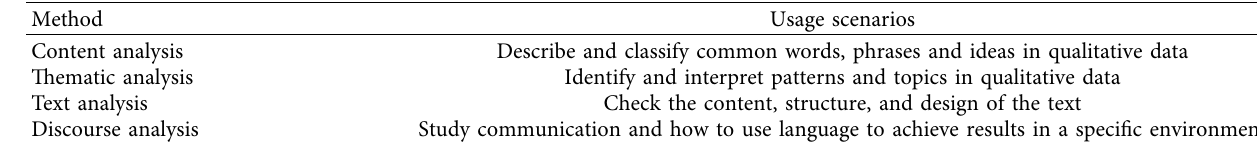
Table 3: Qualitative research data analysis method.